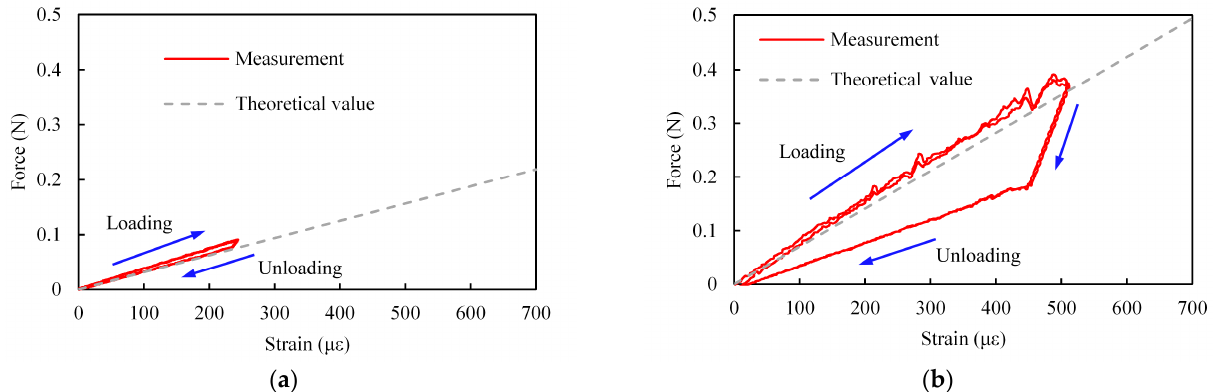
Figure 8. Example of relationship between applied force and strain (sample no. 2, x 2 = 21.1 mm). ( a ) W 1 . ( b ) W 2 . ( a ) W 1 . ( b ) W 2 .